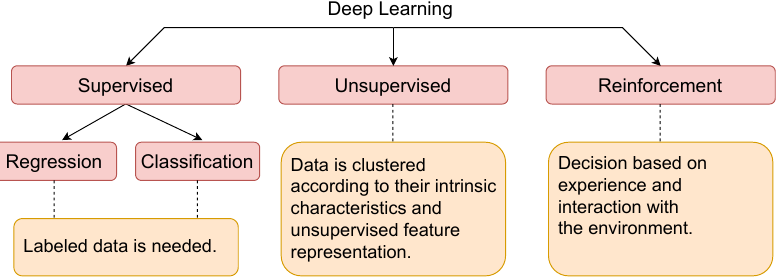
Figure 3. Different deep learning branches: supervised, unsupervised, and reinforcement